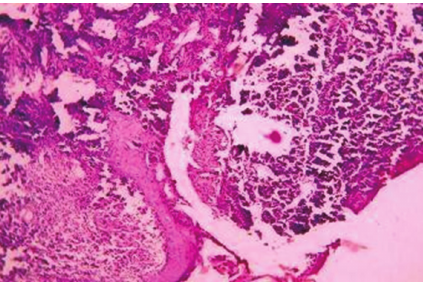
Figure 1: Histological appearance under low magnification.